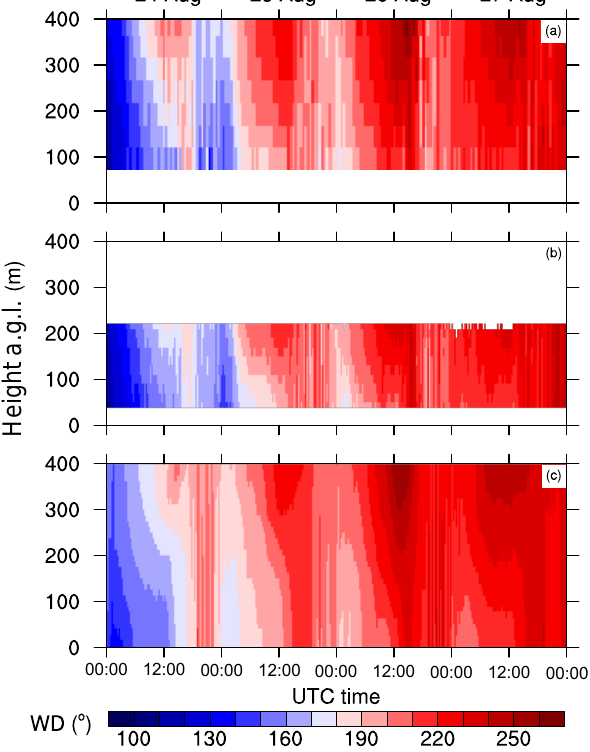
Figure 4. As in Fig. 3, but for WD.